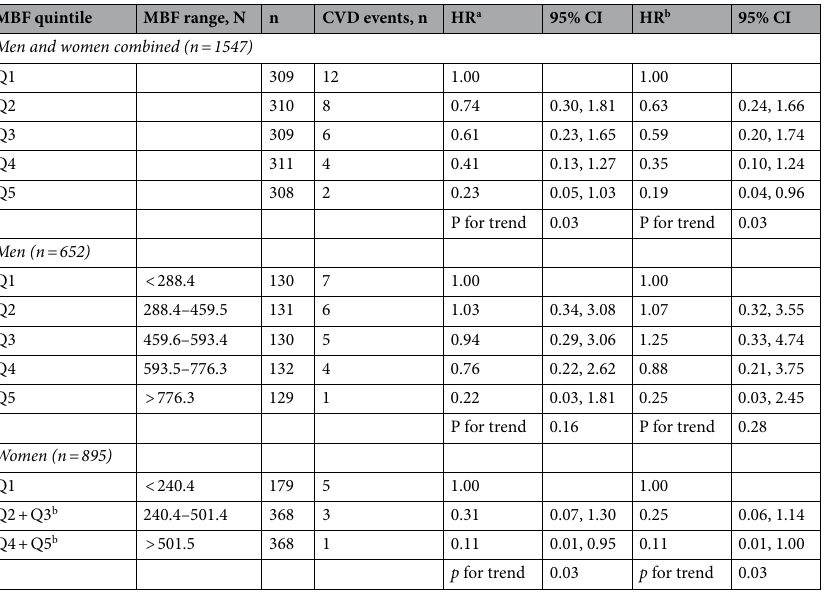
Table 4. Multivariable-adjusted hazard ratios and 95% confidence intervals for CVD by MBF quintile. MBF, maximum bite force; CVD, cardiovascular disease; HR, hazard ratio; C.I., confidence interval. Men and women combined model HR also adjusted for sex. a Adjusted for age. b Adjusted for age, number of functional teeth, periodontitis, BMI, smoking status, drinking status, physical activity, hypertension, hyperlipidaemia, and diabetes